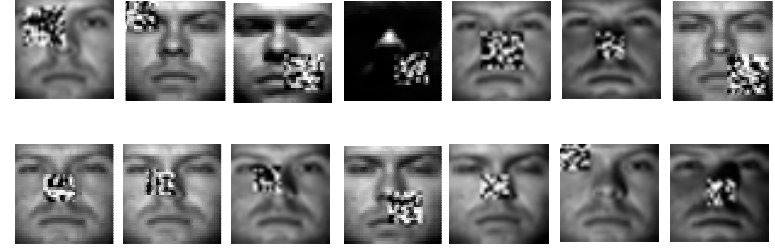
Figure 6. Occlusion samples of one person on the Extended Yale B database. Table 5. Experimental results on the Extended Yale B database by using 1NN classifier and SVM classifier.